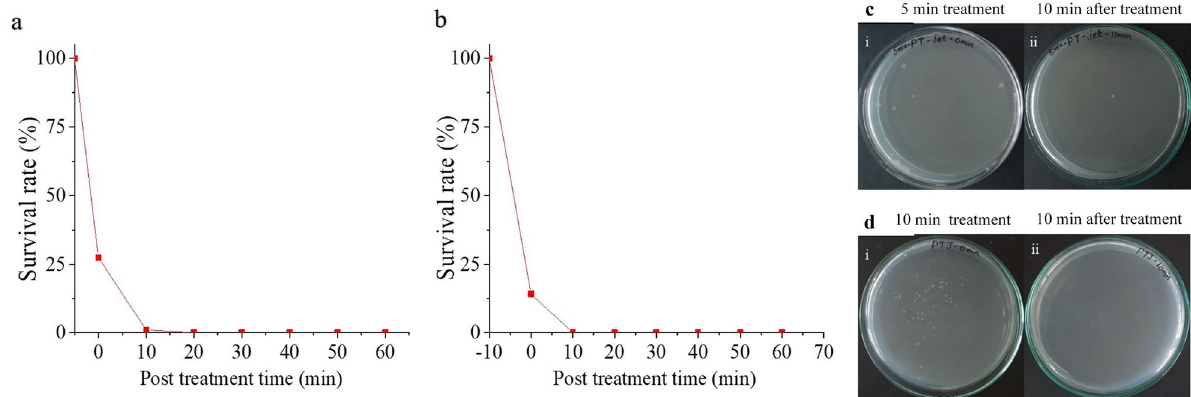
Figure 10. Post treatment analysis for APPJR treated samples-percentage survival rate till 60 min after treatment for ( a ) 5 min APPJR treatment and ( b ) 10 min APPJR treatment; ( c ) E. coli colony formed with 5 min treatment and 10 min after treatment; ( d ) E. coli colony formed with 10 min treatment and 10 min after